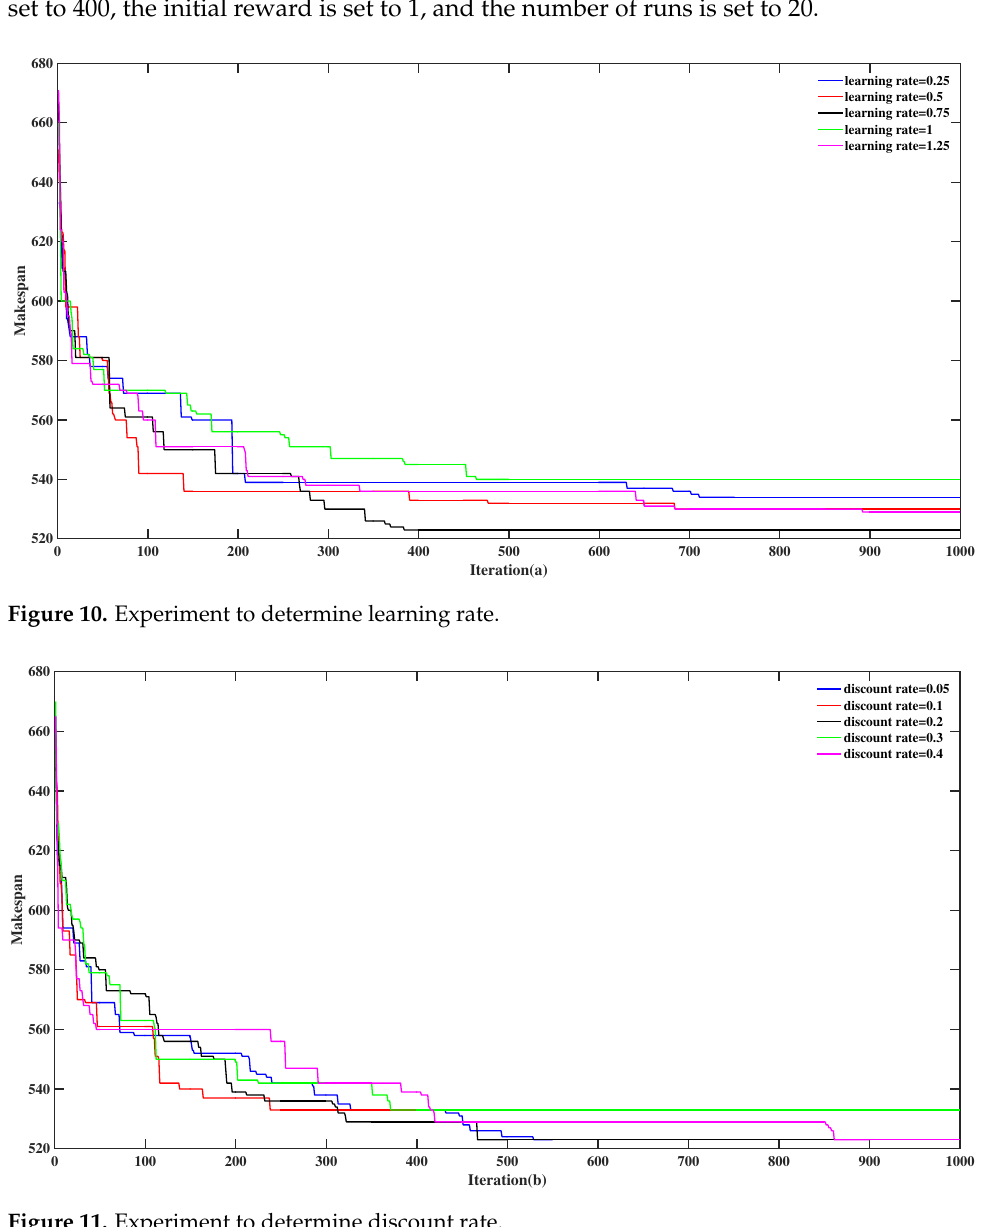
Figure 11. Experiment to determine discount